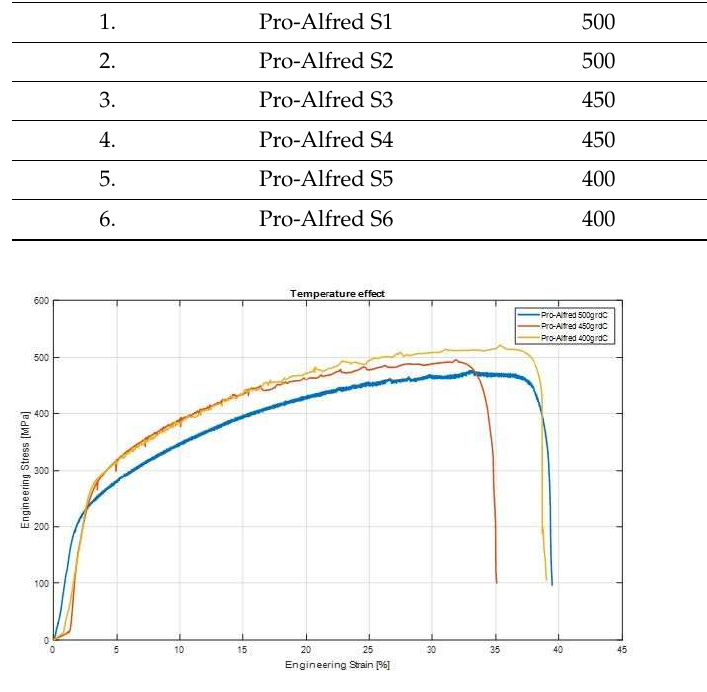
Figure 15. Effect of testing temperature on engineering